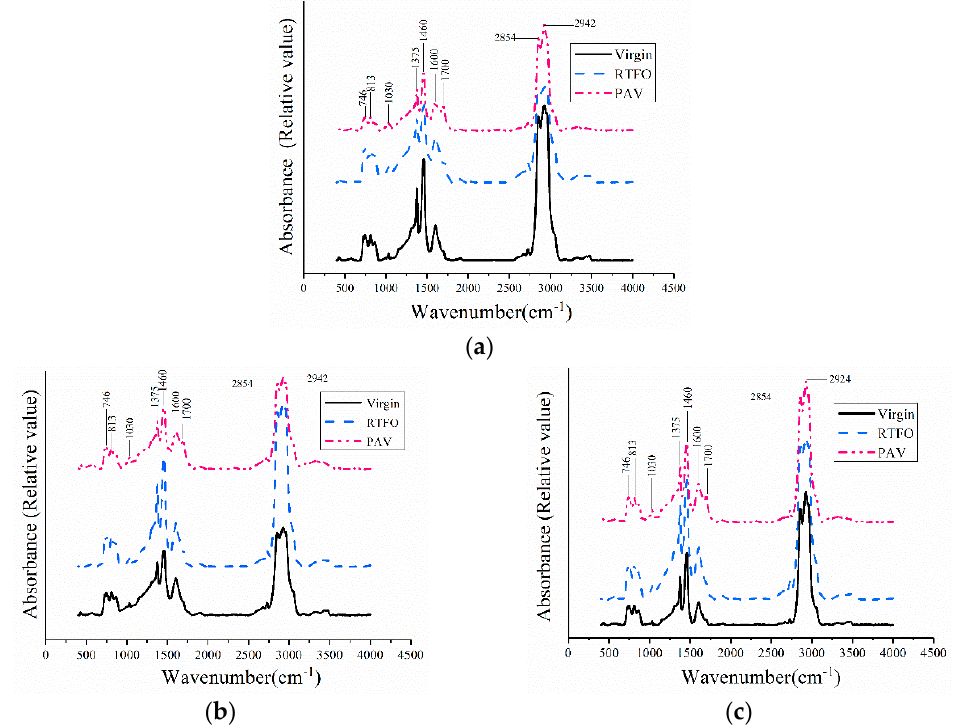
Figure 5. Fourier Transform Infrared Spectroscopy ( FTIR) spectra of different bitumen before and after aging: ( a ) 70# bitumen; ( b ) 50# bitumen; ( c ) 30# bitumen.